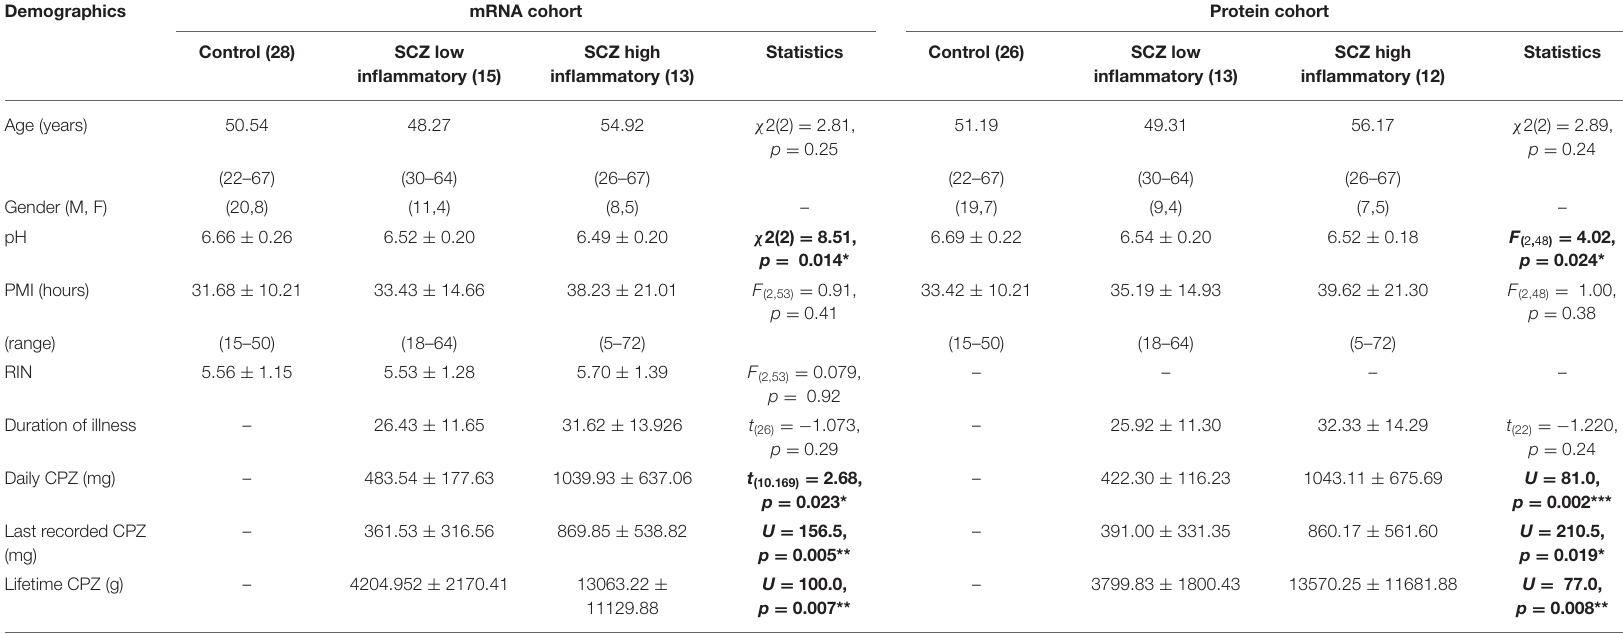
TABLE 1B | Demographic details of the postmortem midbrain mRNA and protein cohorts classified by inflammatory